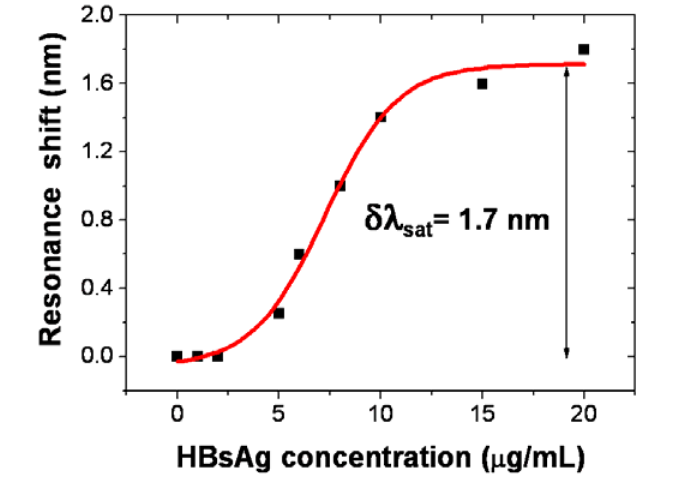
Figure 5. Resonance wavelength shift of a 70- μ m-radius Si resonator as a function of hepatitis B surface antigen (HBsAg) concentration [20]. Square dots: experimental data; red line: sigmoidal